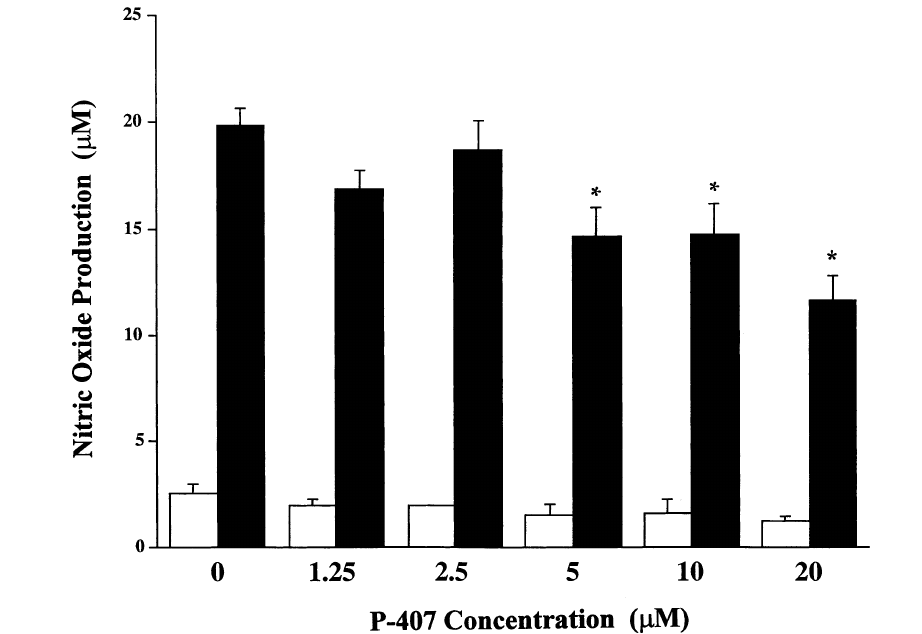
FIG. 3. Effect of P-407 on the release of NO from rat peritoneal macrophages in the absence ( I ) and presence ( j ) of LPS (50 ng/ml) at 24 h. * Significant (p B / 0.05) decrease in the NO released when individually compared with the NO concentration determined at 0 m M P-407.